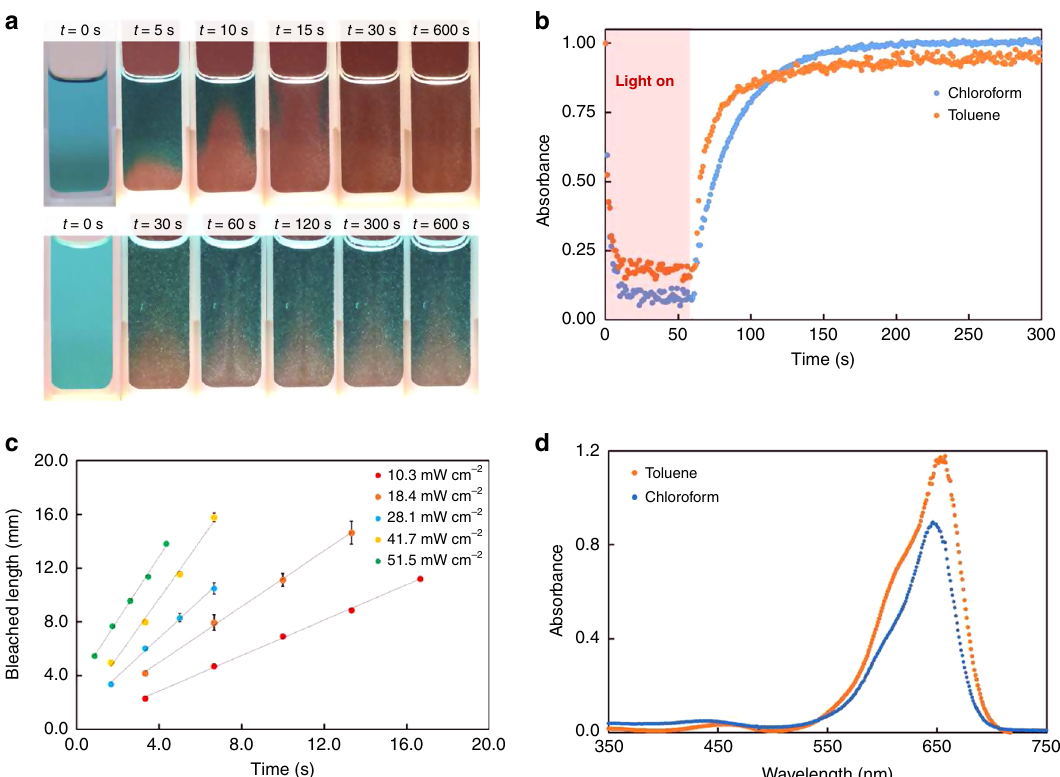
Fig. 2 Photochemical properties of DASA-CF 3 -PI in chloroform and toluene. a Bleaching front progression through 0.25 mM DASA-CF 3 -PI in chloroform stabilized with 0.75% ethanol (top) and toluene (bottom) irradiated with 25 mW cm − 2 light. b Reversible switching kinetics of DASA-CF 3 -PI in chloroform and toluene at 10 μ M. c Bleaching front length versus time for 0.125 mM DASA in chloroform, where the slope provides a measure of the front velocity. d Absorbance of DASA-CF 3 -PI in toluene and chloroform at 14 μ